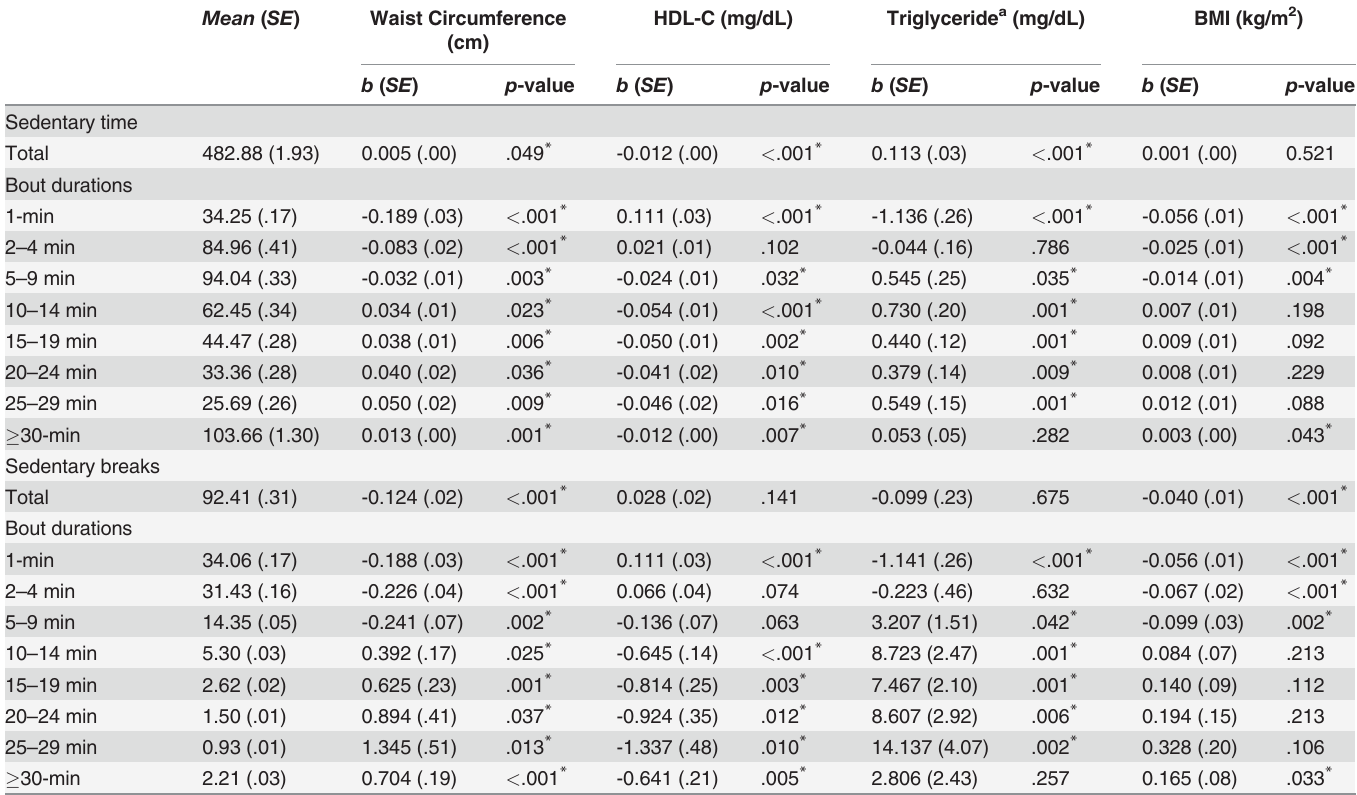
Table 3. Associations of Accelerometer Determined Sedentary Behavior Measures with Health Outcomes across the Bout Durations ( n =